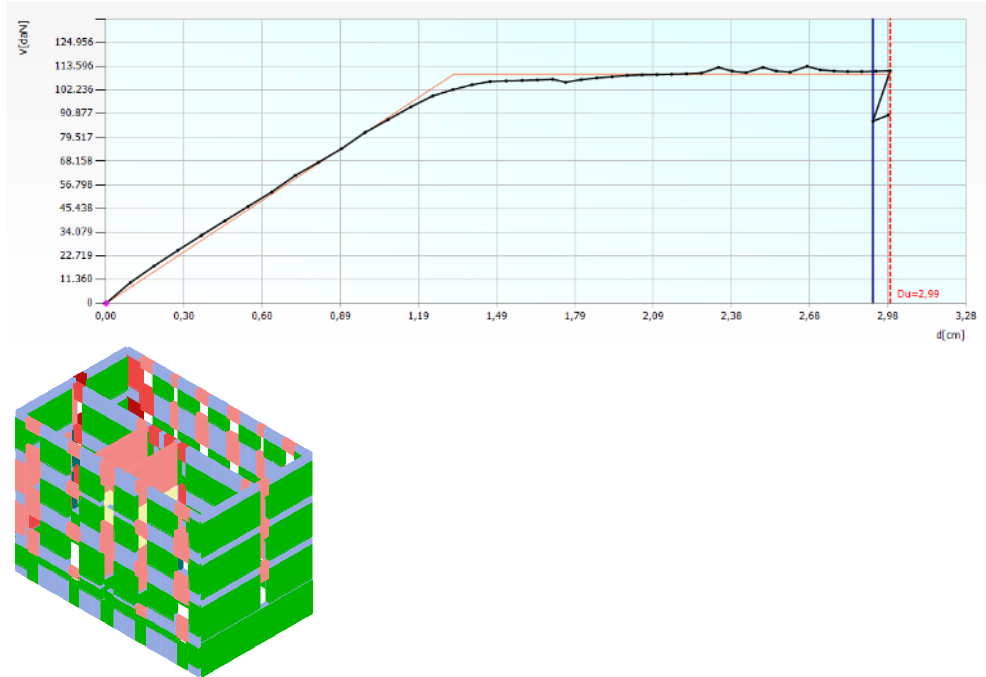
Figure 12. Results of analysis No. 22 in Y-direction on the bare building.